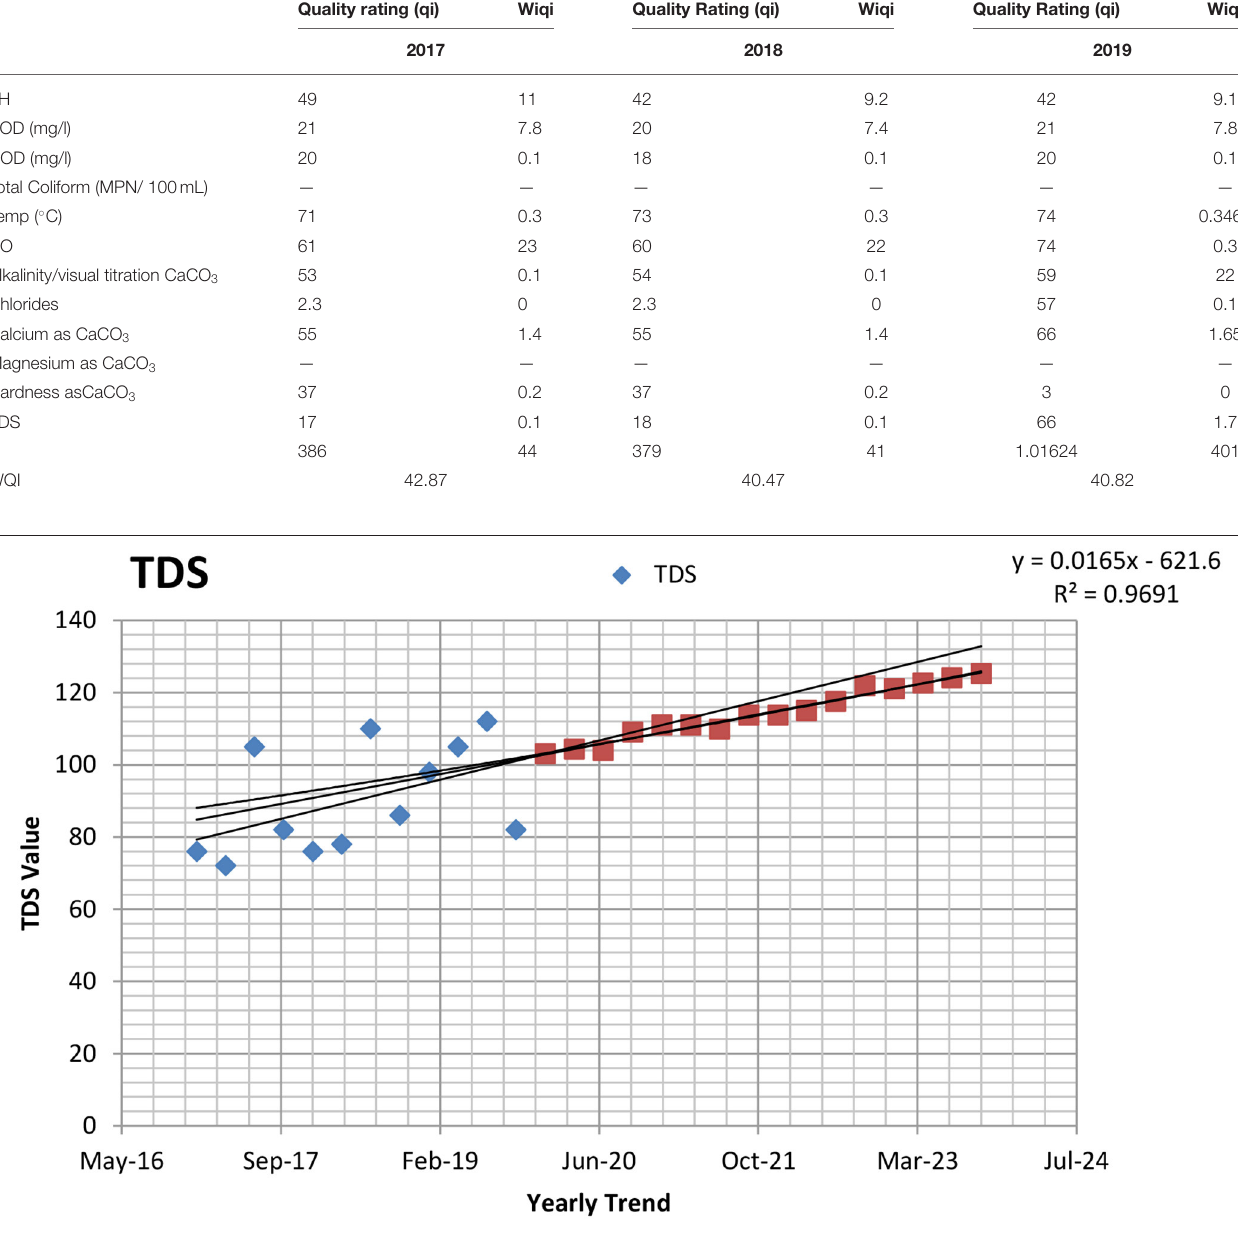
FIGURE 9 | Trend forecasting of TDS at Dehradun for the years from 2020 to